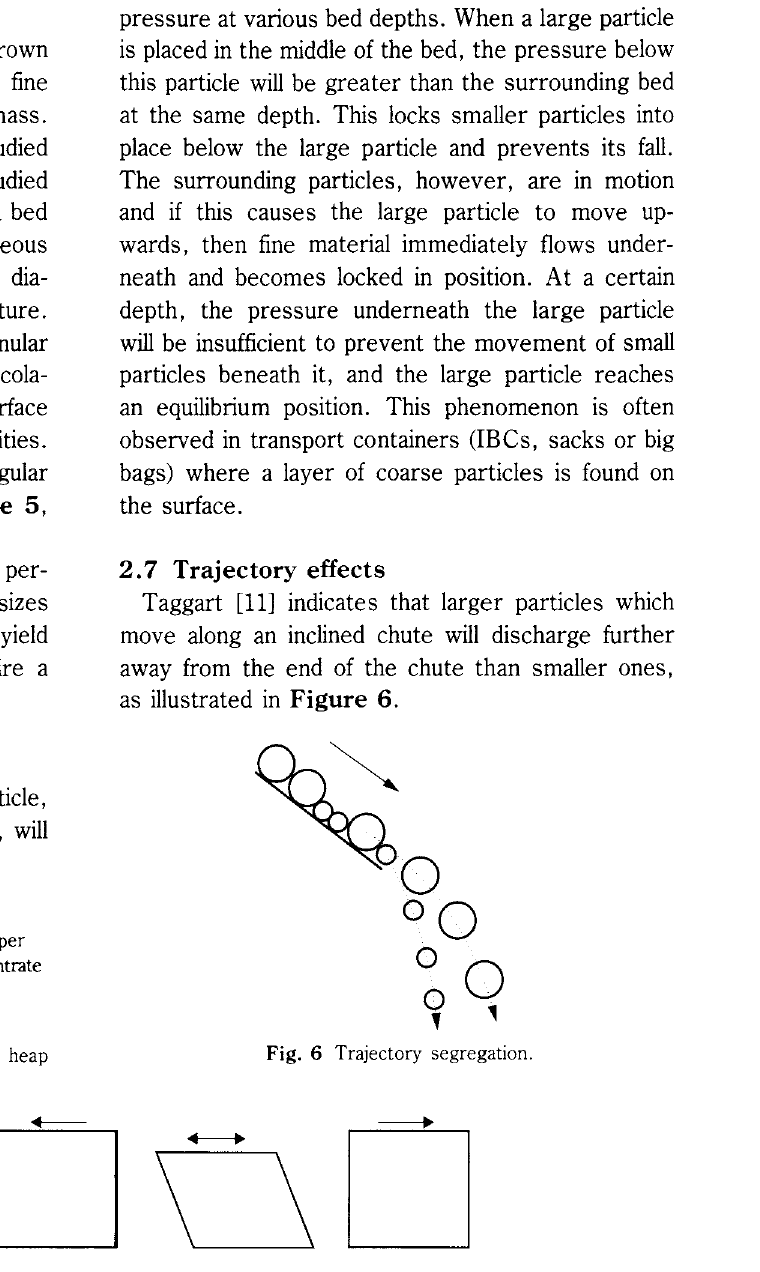
Fig. 4 Concentration of a coarse sand in the centre of a heap due to angle-of-repose effects.